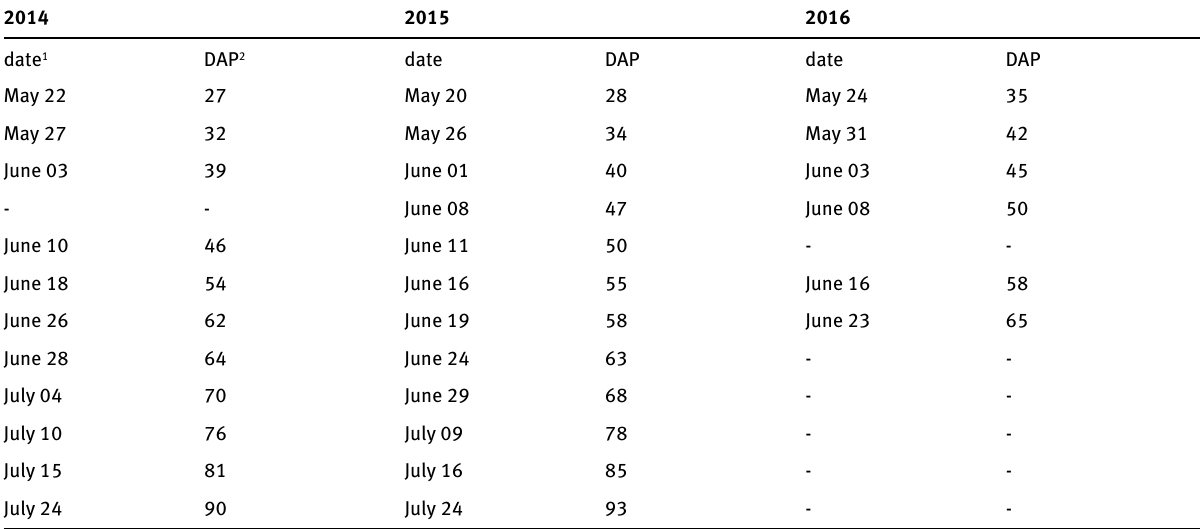
Table 3: Dates of sensor measurements the Hollage